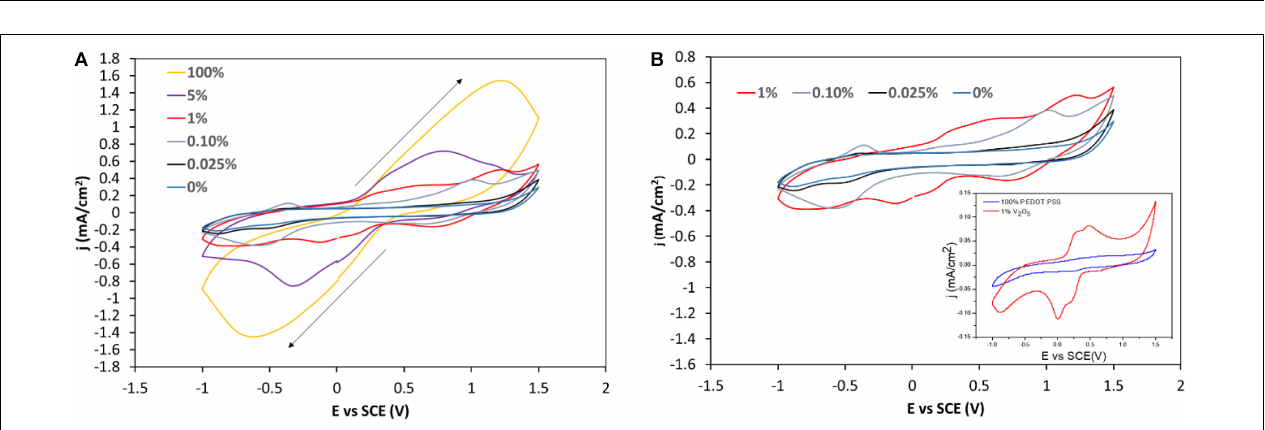
FIGURE 4 | SEM of the (a) 100%PEDOT:PSS. (b) film hybrid 99 wt%–1 wt% PEDOT:PSS-V 2 O 5 . (c) film hybrid 95 wt%–5 wt% PEDOT:PSS-V 2 O 5 . (d) film hybrid 90 wt%–10 wt% PEDOT:PSS-V 2 O 5 . (e) 100 wt% V 2 O 5 film.